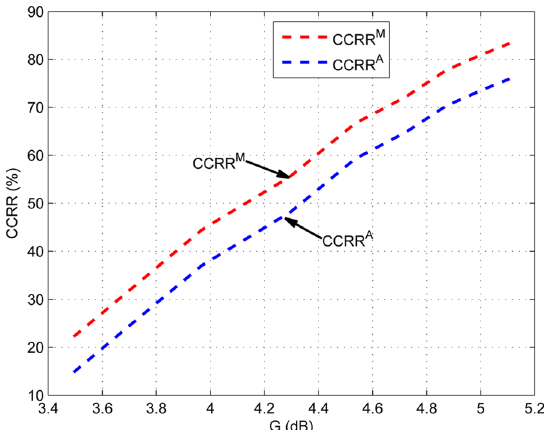
Fig. 9 CCRR of the proposed SLM technique vs. PAPR reduction gain, in terms of RA and